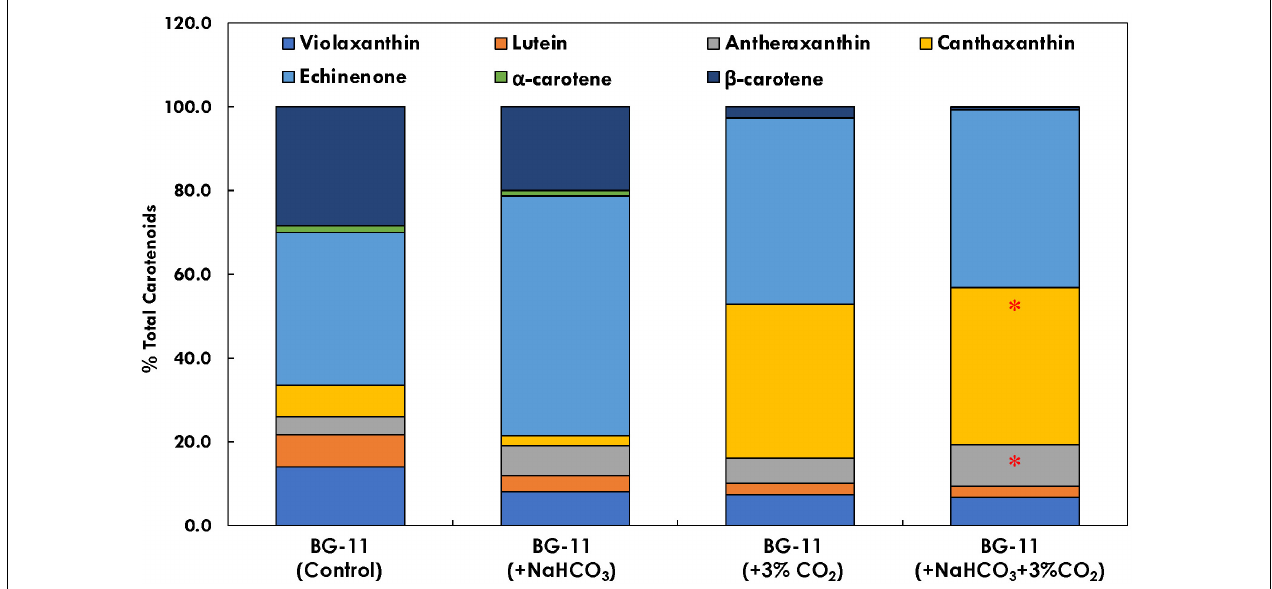
FIGURE 7 | Bar plot depicting the distribution of individual carotenoids (% total carotenoid content) in Botryococcus braunii subjected to different carbon supplementations. * Statistical significance by one-way ANOVA, p < 0.05.